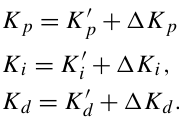
3 Fuzzy PID controller